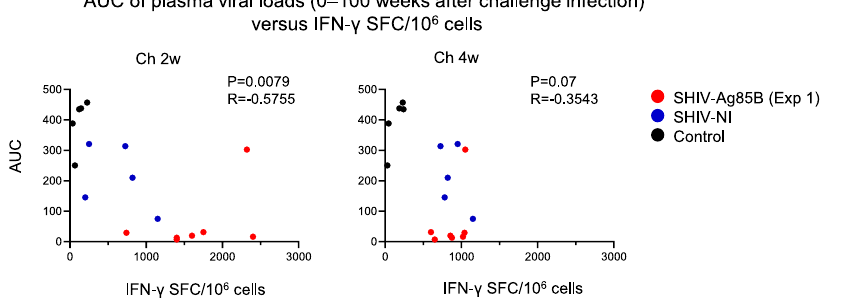
Fig. 8 Inverse correlation analyses between protective T cell responses and AUC of plasma viral loads. Analysis of correlation between Gag/pol-speci fi c IFN- γ -producing cells at 2 or 4 weeks post challenge infection and AUC of plasma viral loads. AUC was inversely correlated with Gag/pol-speci fi c IFN- γ -producing cells at 2 weeks post challenge infection ( p = 0.0079, r = − 0.5755). No signi fi cant correlation was observed between AUC and Gag/pol-speci fi c IFN- γ -producing cells at 4 weeks post challenge infection. Statistical analyses were performed using Spearman